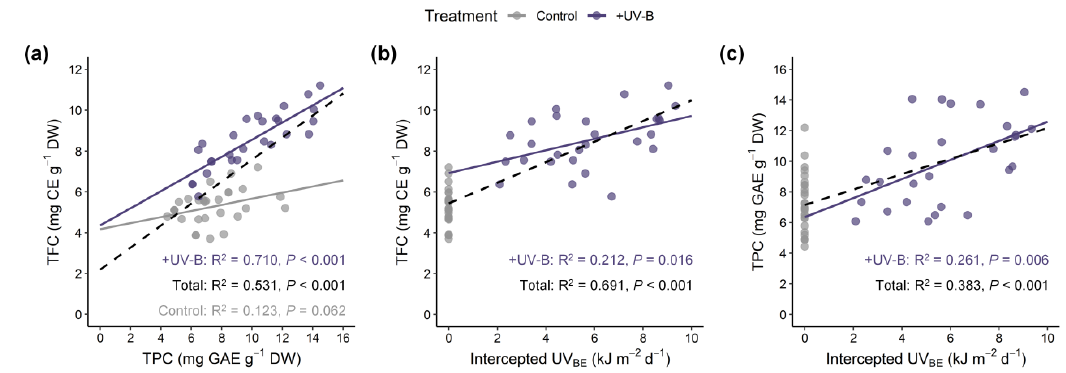
Figure 4. Relationship between total flavonoid content (TFC), total phenolic content (TPC) and UV radiation interception of kale leaves within whole plants grown under the control and UV-B treatment (+UV-B). TPC versus TFC ( a ); UV radiation interception versus TFC ( b ) or TPC ( c ). The lines show linear fits of the +UV-B data set ( n = 27, purple solid line), the control data set ( n = 29, gray solid line) and the entire data set ( n = 56, gray dashed line). The R 2 and p -value for each regression are shown within the panels.